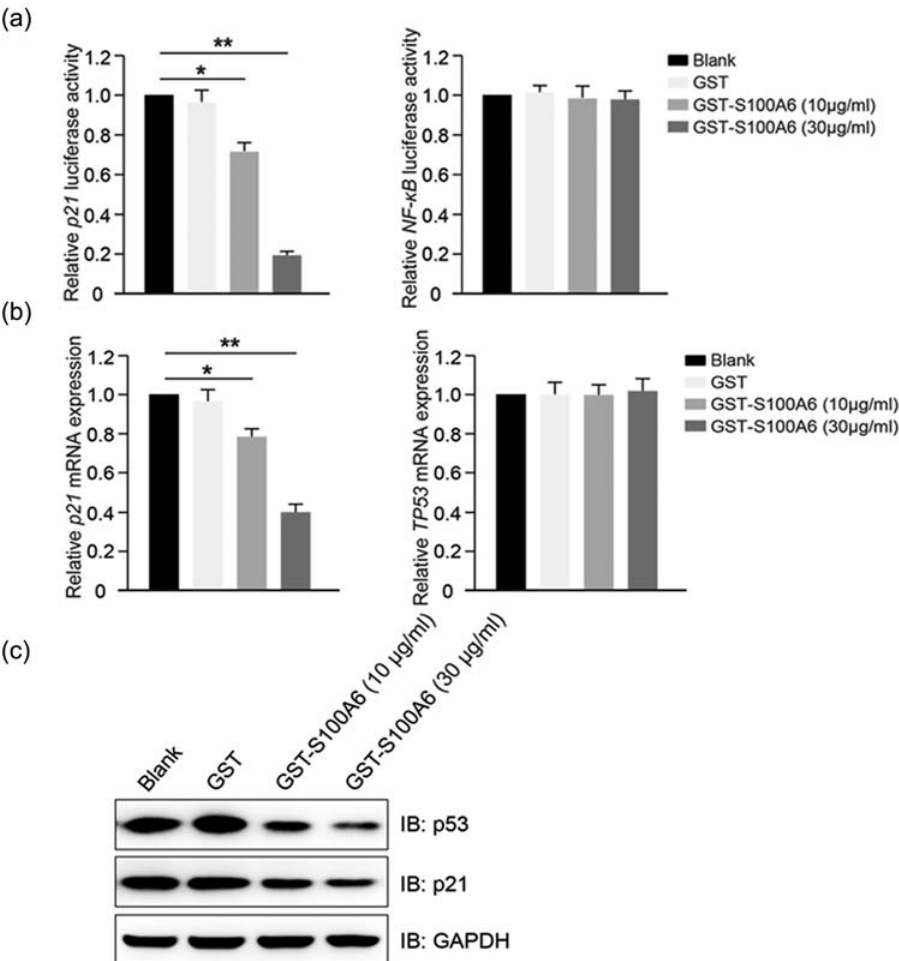
Figure 5: Exogenous S100A6 promotes the degradation of p53. ( a ) Detection of the p21 and NF - κ B luciferase activities of HepG2 cells that treated with GST or GST - S100A6; * P < 0.05 and ** P < 0.01. ( b ) Detection of the p21 and p53 mRNA levels of HepG2 cells treated with GST or GST - S100A6 for 48 h; * P < 0.05 and ** P < 0.01. ( c ) Immunoblotting shows the p21 and p53 protein levels in HepG2 cells treated with GST or GST -